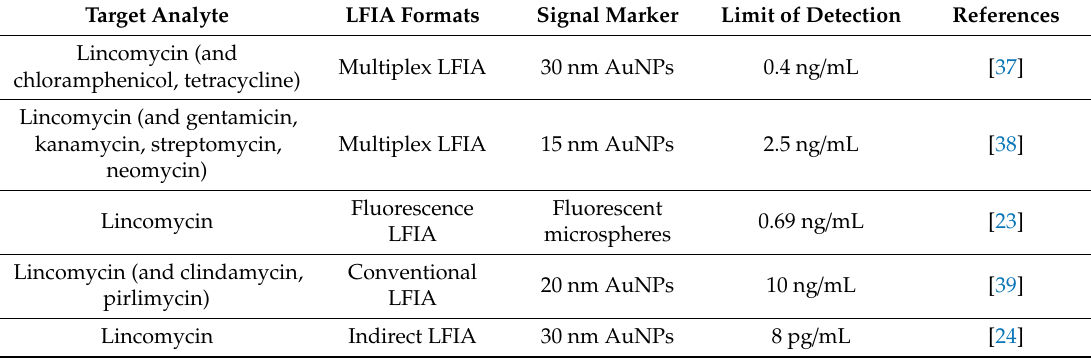
Abbreviations: AuNPs—gold